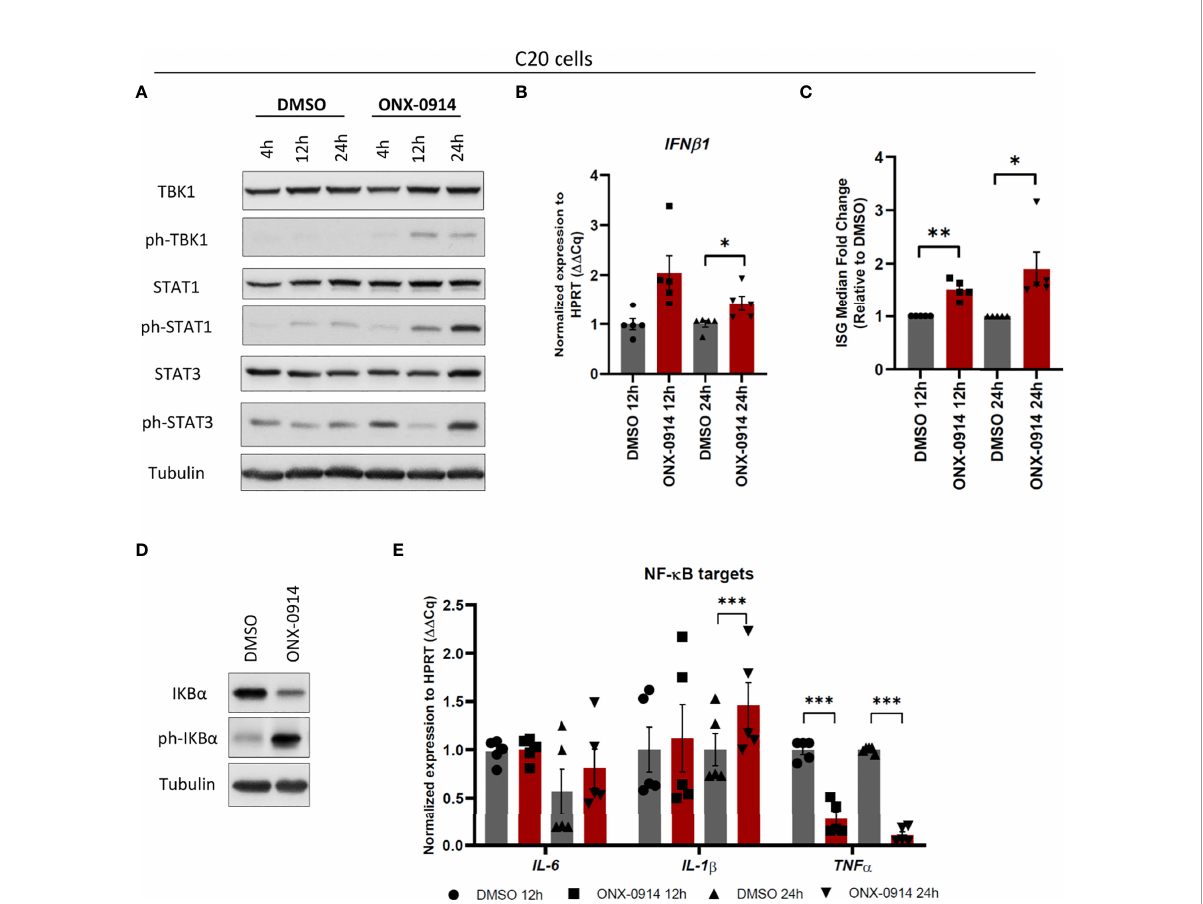
FIGURE 5 b 5i/LMP7 activity inhibition controls activation of innate immune responses in C20 cells. (A) Western blot analysis of type I IFN response proteins in C20 cells treated with 200nM of ONX-0914 for indicated time (n=3). (B, C) Quantitative reverse transcription PCR (qRT-PCR) analysis of IFN b 1 (B) , and IFN score (C) calculated by interferon stimulated genes (ISGs) median fold change in C20 cells treated with 200nM of ONX-0914 for indicated time (n=5). (D) Western blot analysis of NF- k B pathway proteins in C20 cells treated with 200nM of ONX-0914 for 24h (n=3). (E) qRT- PCR analysis of NF- k B targets in C20 cells treated with 200nM of ONX-0914 for indicated time (n=5). Mean ± SEM; *: P < 0.05, **: P < 0.01, ***: P <